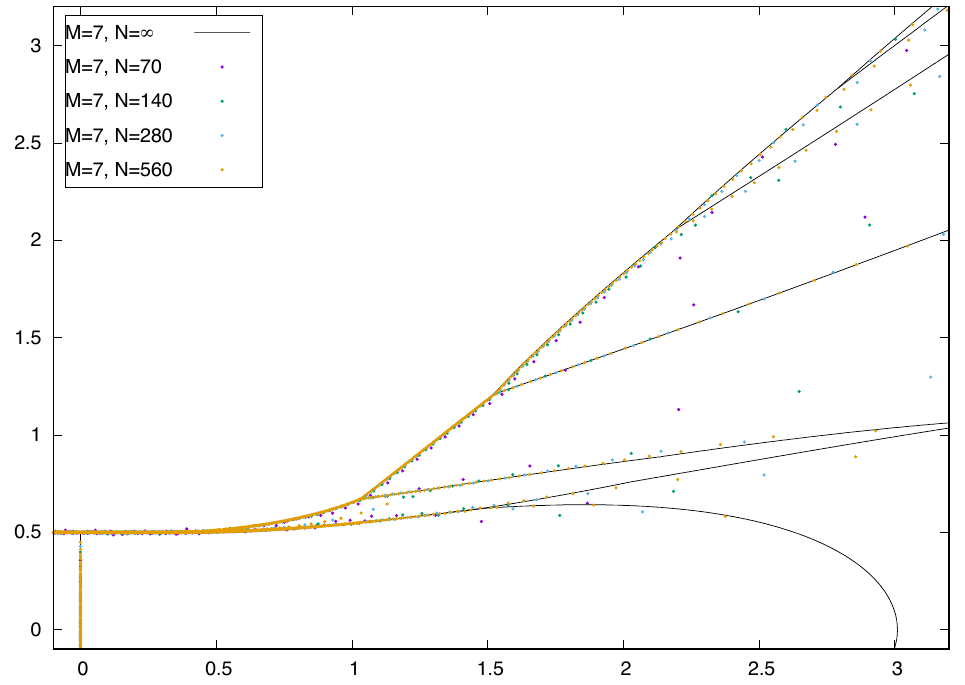
Figure 7 . Comparison between the limiting curves and the partition function zeros for M = 7.